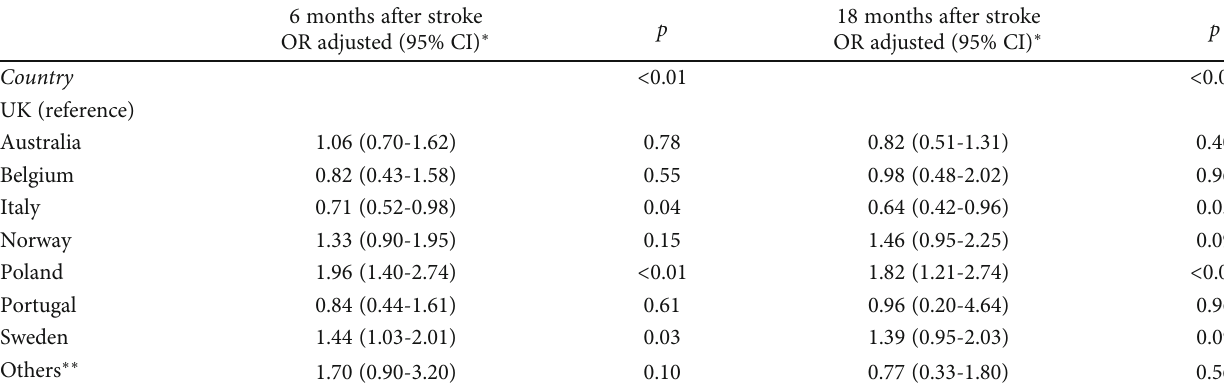
Table 6: Di ff erences between countries in the fi nal